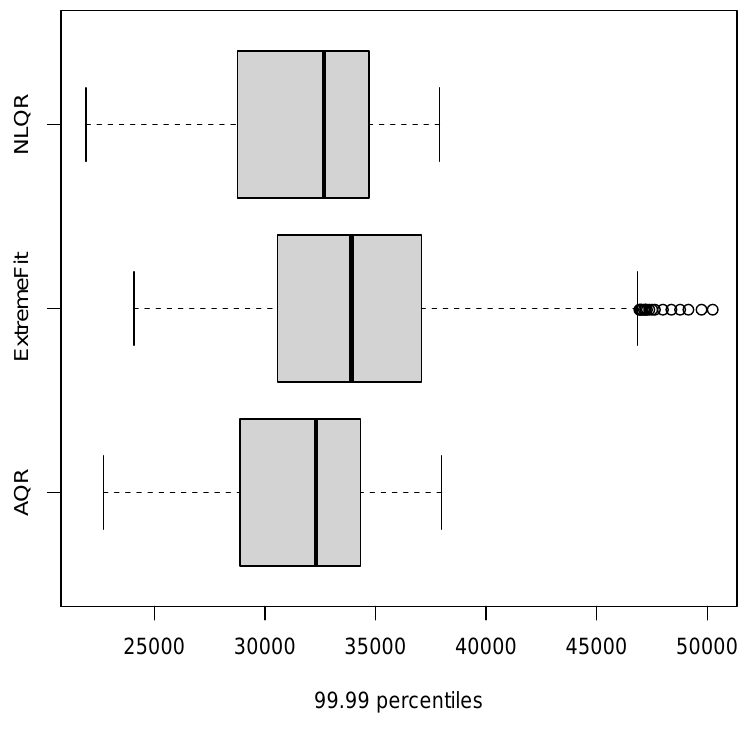
Figure 8. Box plots of the 0.9999 quantile.